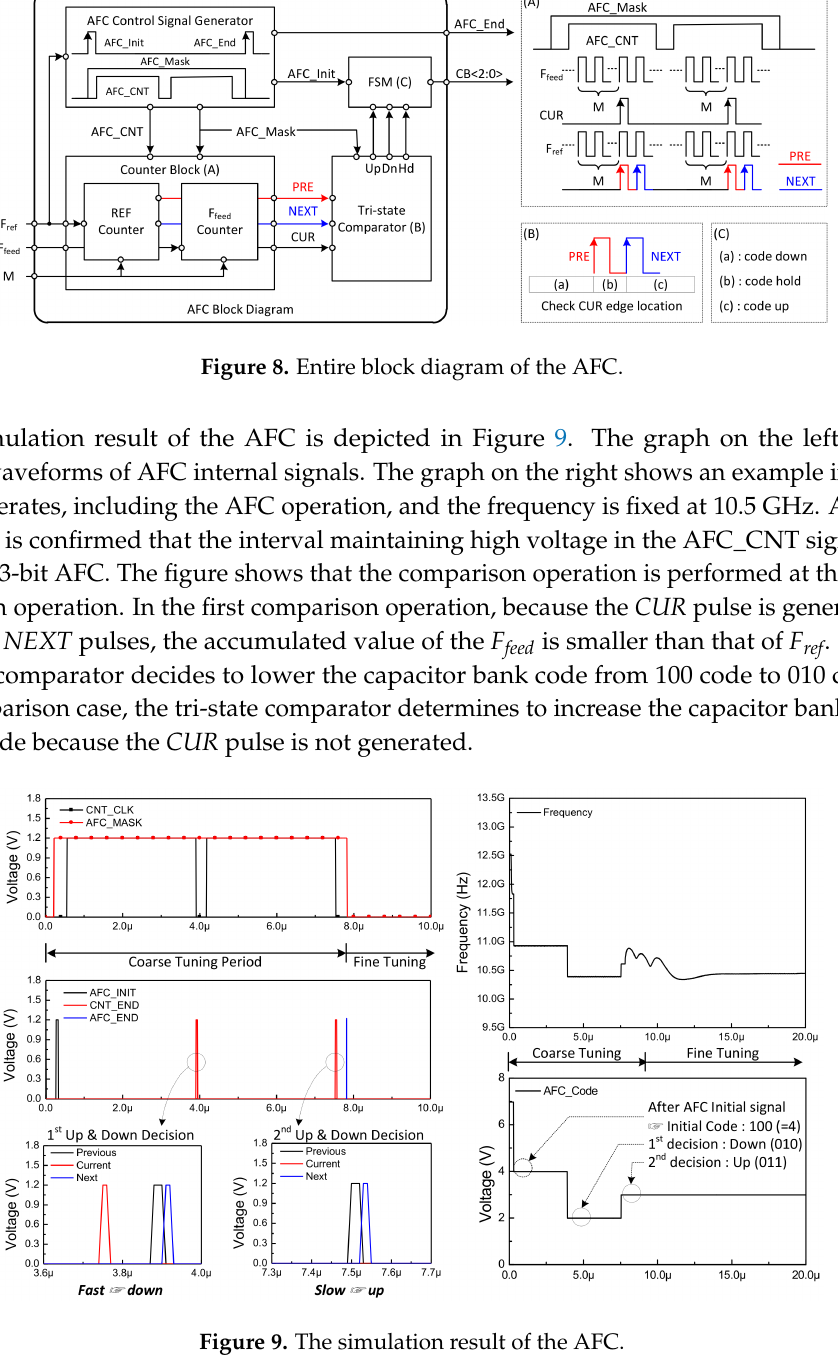
Figure 9. The simulation result of the